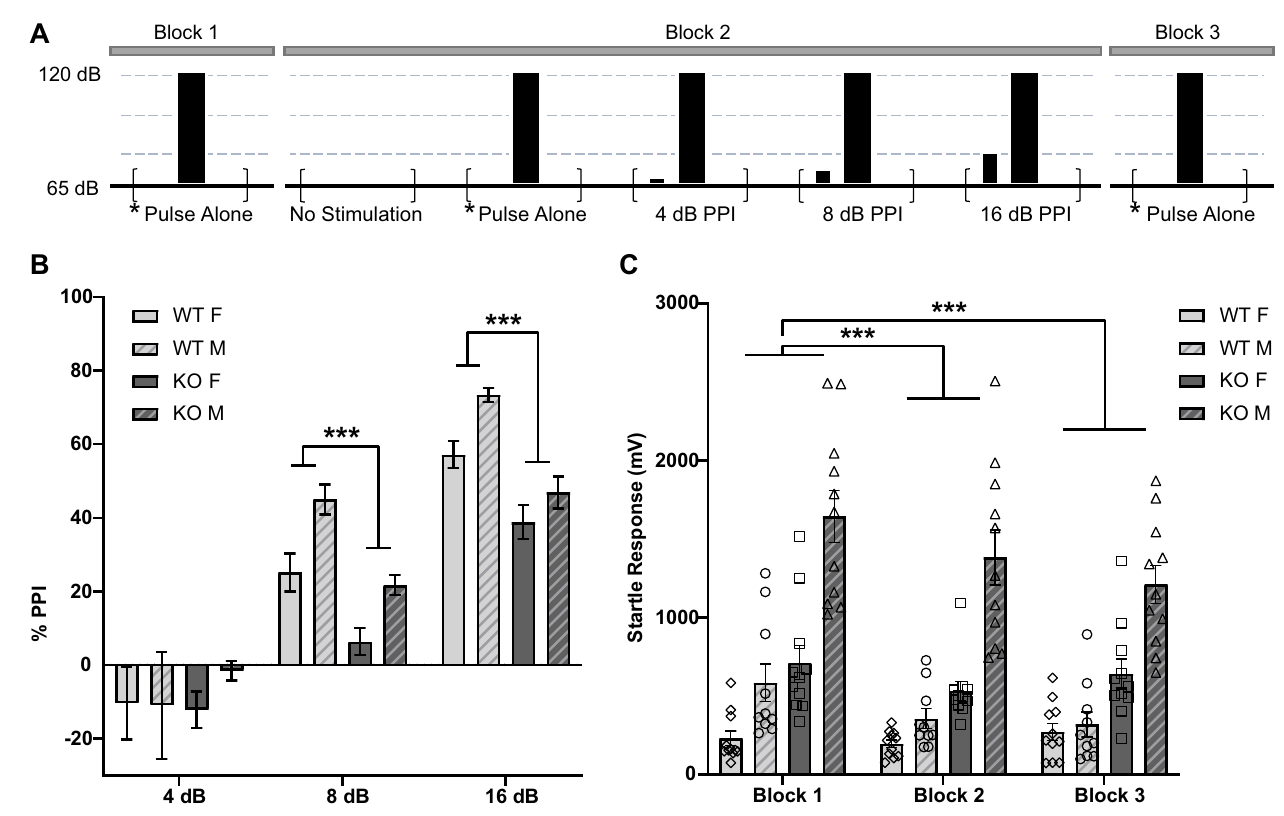
Fig 1. α 2 δ -4 KO mice exhibit impaired PPI (A), Schematic of PPI session design. Block 1 & 3 each consist of 6 test pulses (120 dB) alone trials. In block 2, animals were exposed to a period of no stimulation, the test pulse alone, or test pulses preceded by a PPI prepulse of 4, 8, or 12 dB. Each trial type (total of 12) was presented in a randomized order with varying intertrial interval. Each test pulse was 40 ms and prepulse was 20 ms in duration. (B) %PPI evoked by the indicated prepulse intensities. (C) Startle response amplitudes evoked by test pulses without prepulses. � p < 0.05; �� p < 0.01; ��� p < 0.001 by linear mixed